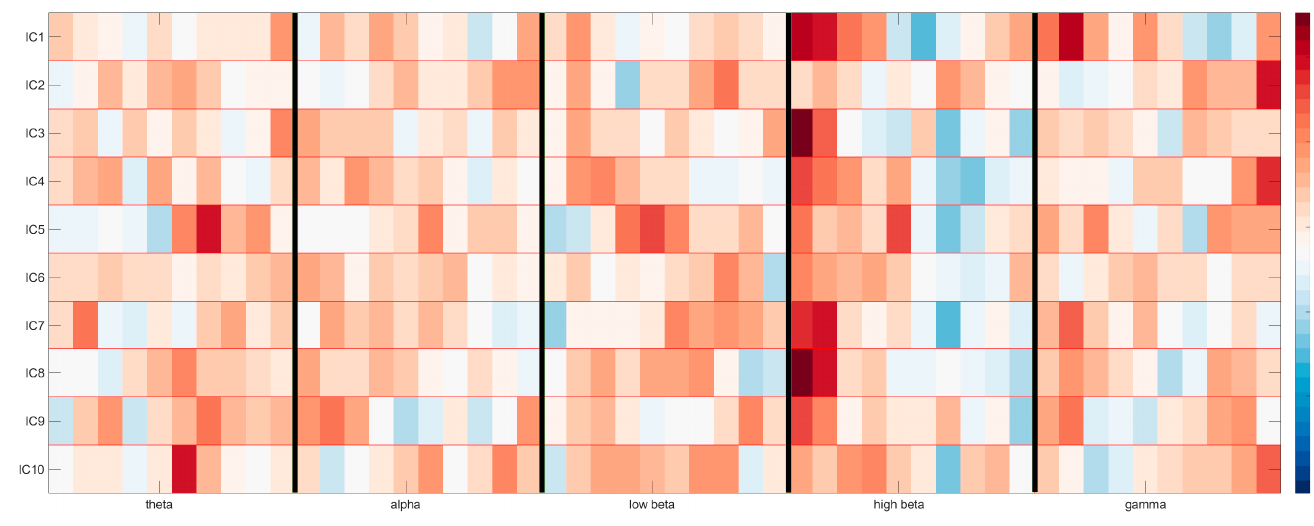
Figure 9. Reprojection of the time-frequency domain of 10 brain components as weighted by the classification model. The y-axis contains the ICs, whereas the x-axis is split into 10 time bins for each of the 5 chosen frequency bands, separated by vertical black lines. Maximum activations can be seen as red, minimum activations as blue.